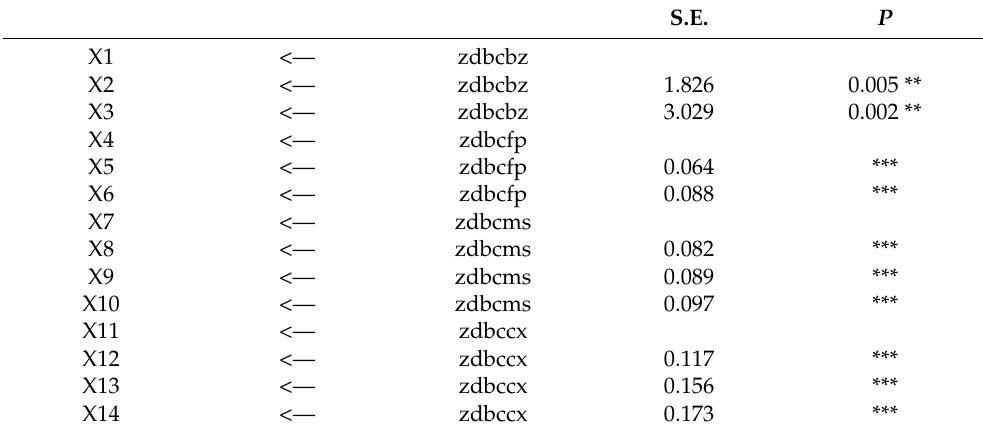
Table 8. The relationship between the land expropriation compensation standard and farmers’